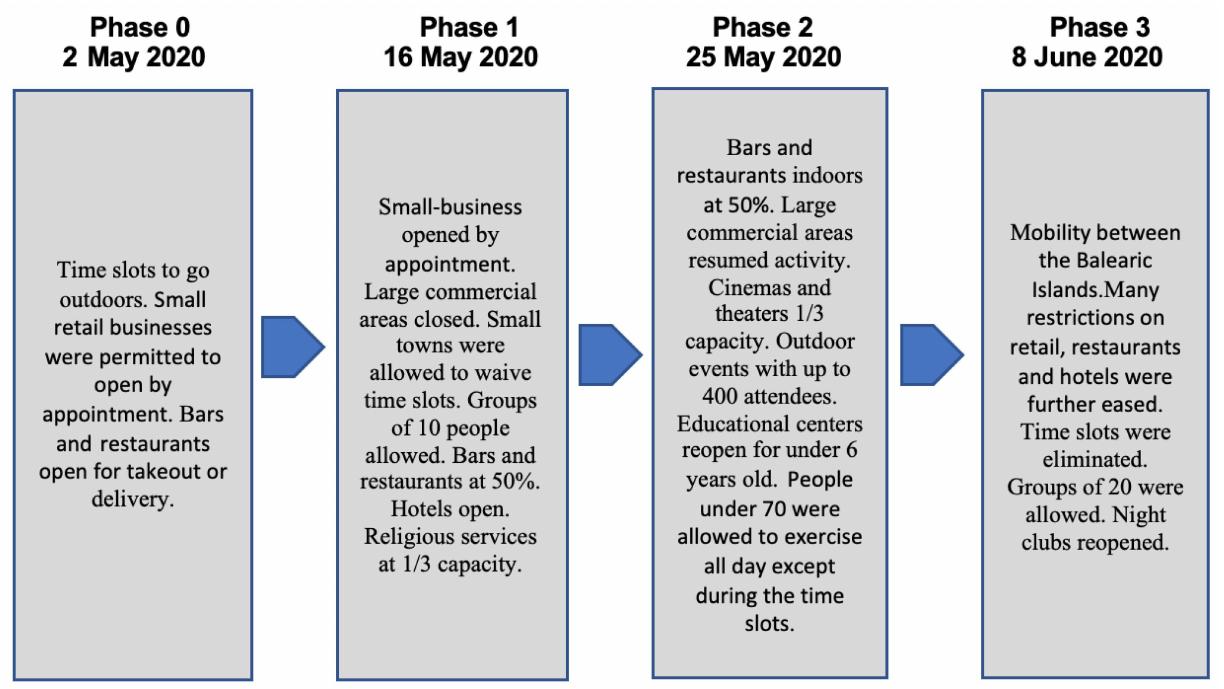
Figure 1. Emergency response and recovery phases: steps and